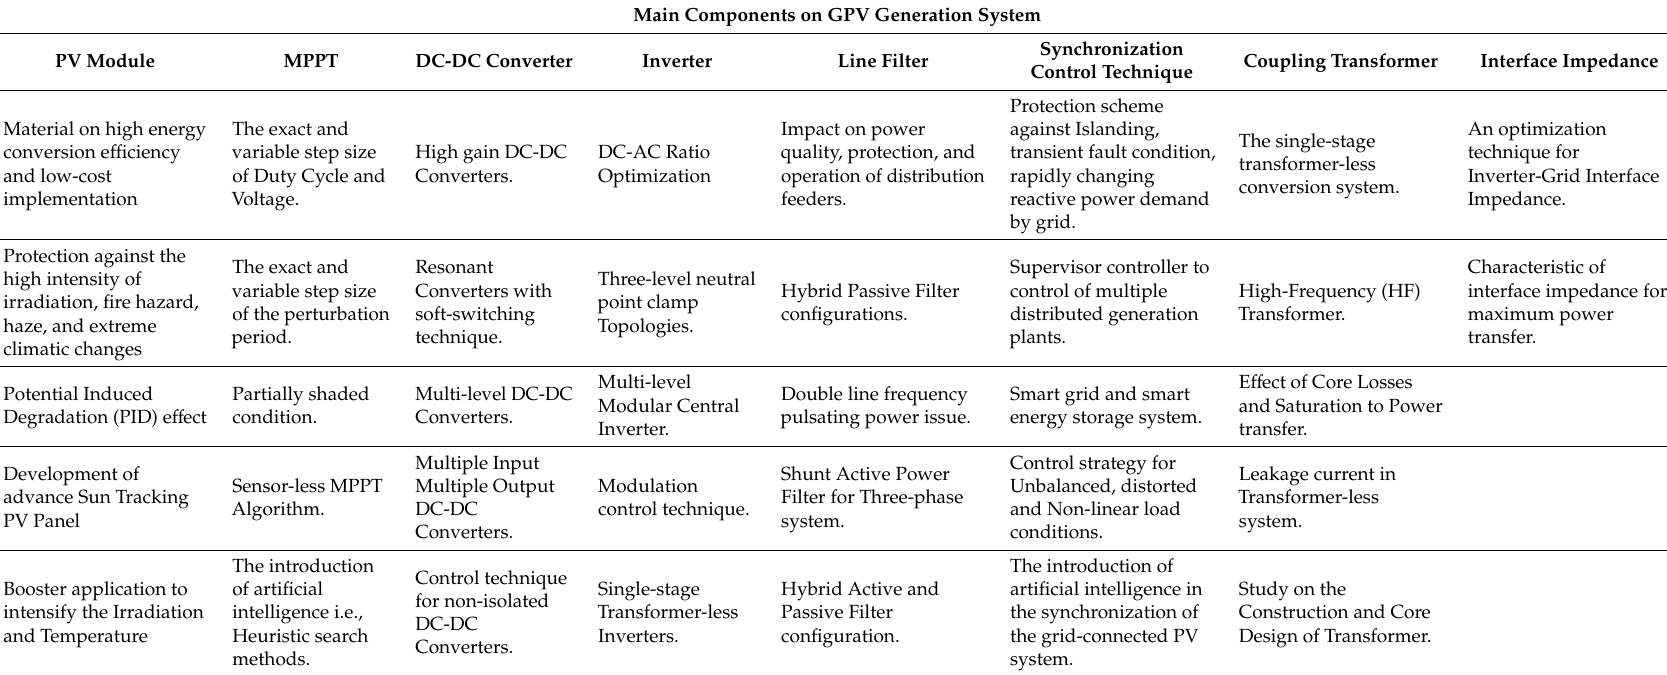
Table 5. Future key challenges on GPV generation system